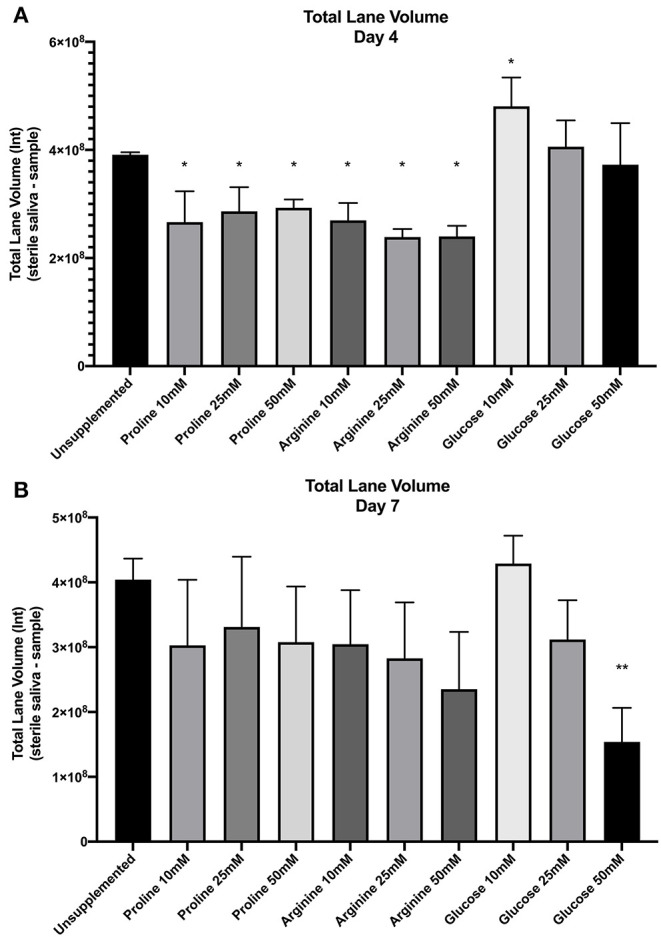
SDS-PAGE total lane volume (arbitrary intensity units; Int) of biofilm spent saliva at day 4 (A) and day 7 (B). Total lane volume was calculated as the total lane volume intensity of the sterile saliva growth medium minus the total lane volume intensity of the spent saliva sample (n = 3; *p < 0.05, **p < 0.005).